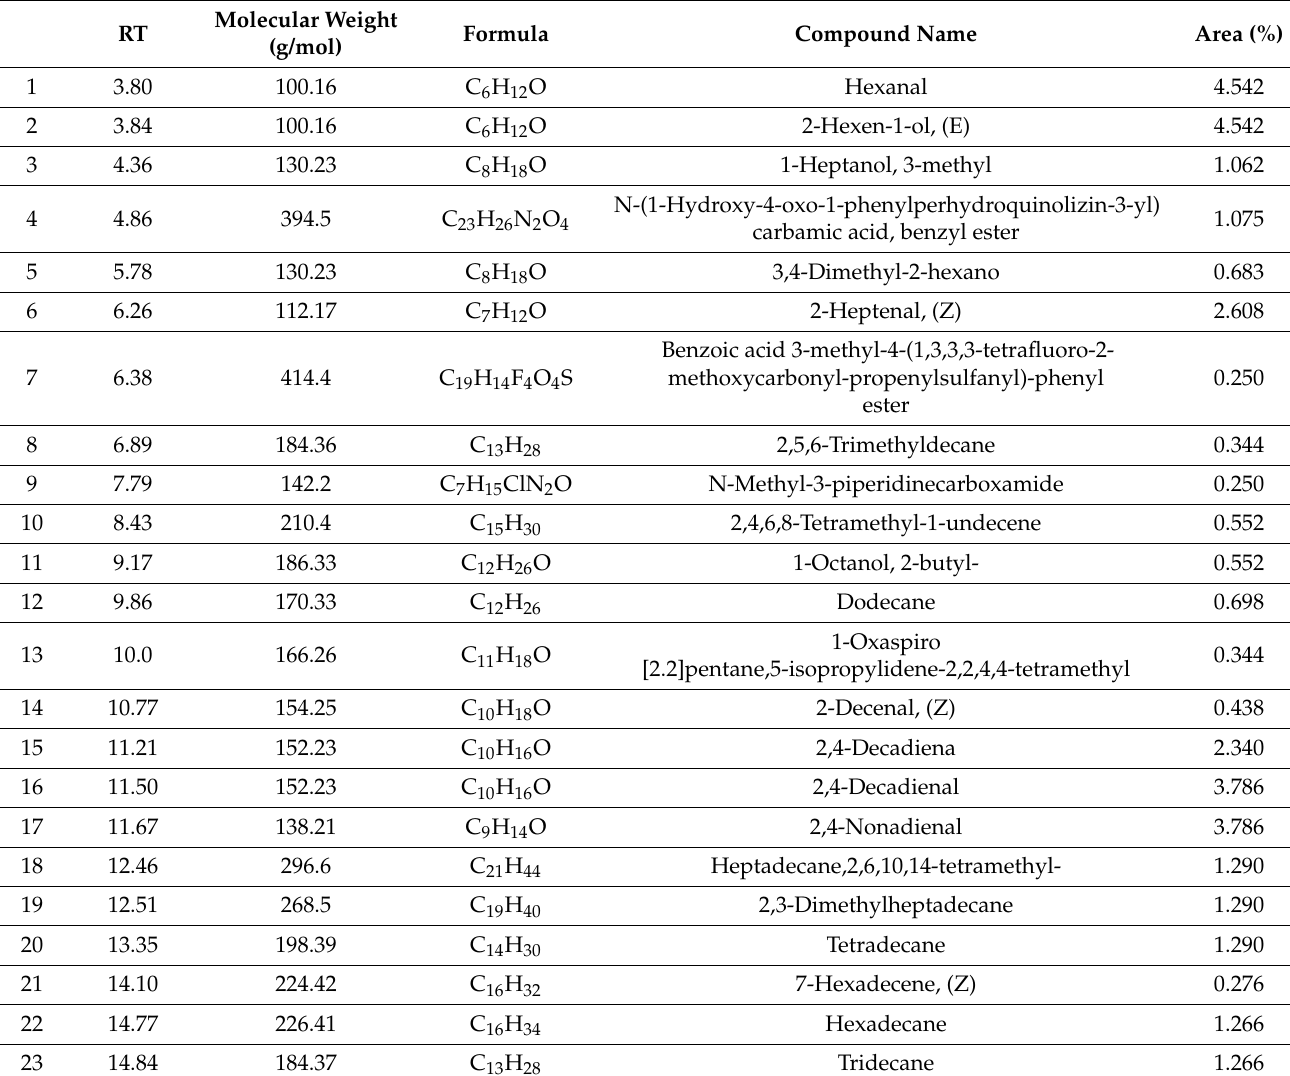
Figure 3. Chromatogram of the characterized extract from B. hispanica. Table 2. Chemical compounds identified in the methanol extract of B. hispanica bark.